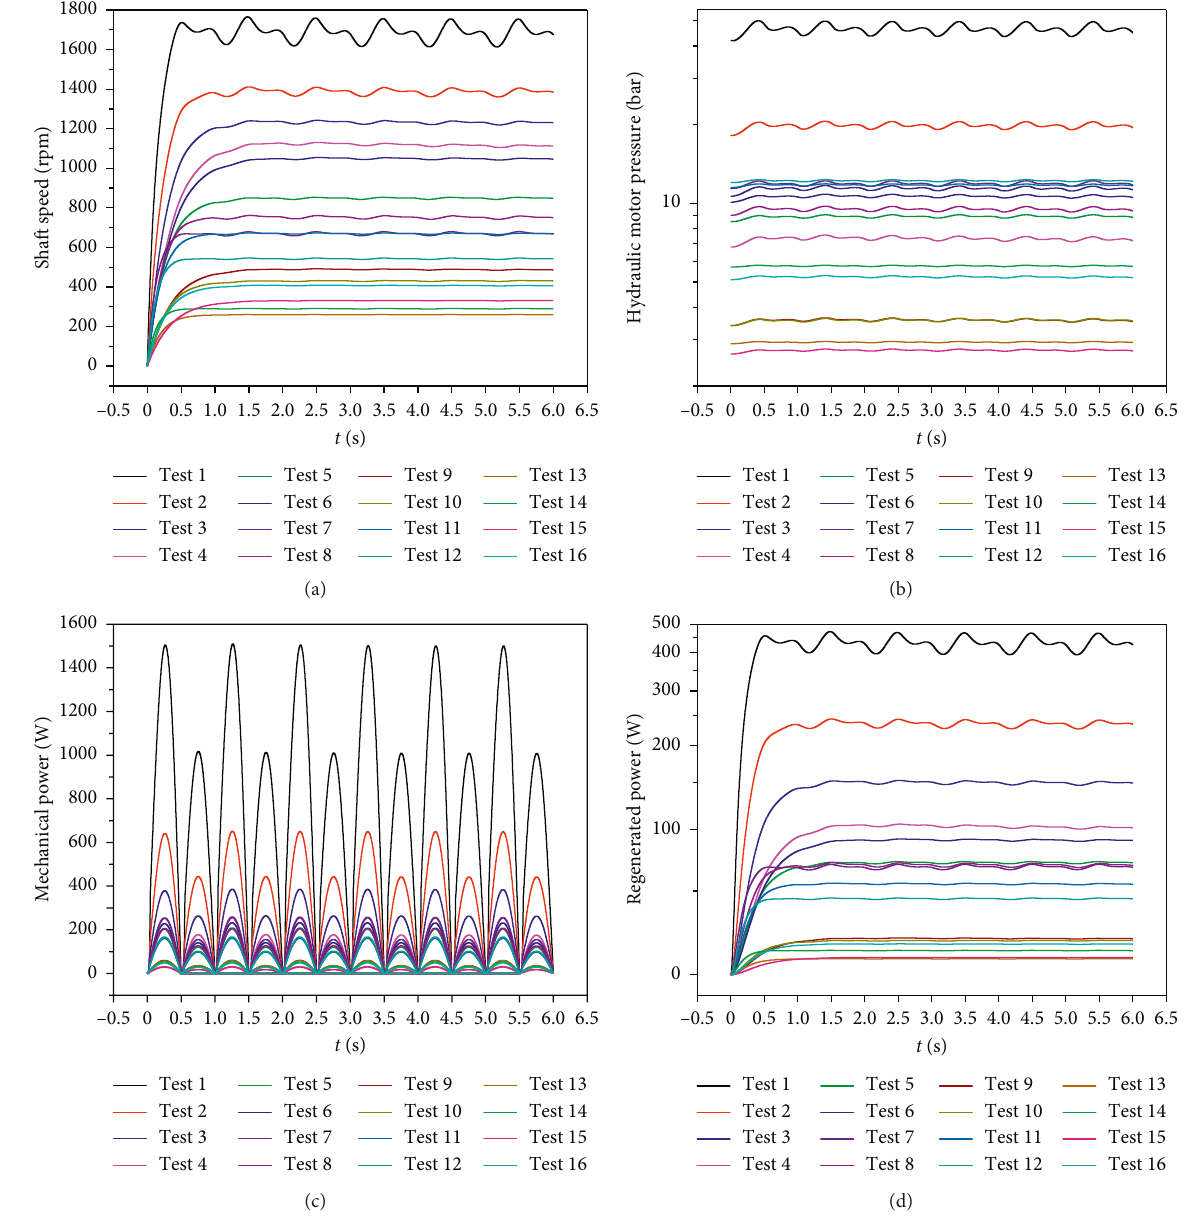
Figure 5: Hydraulic motor shaft speed, pressure, mechanical power, and regenerated power at different 16